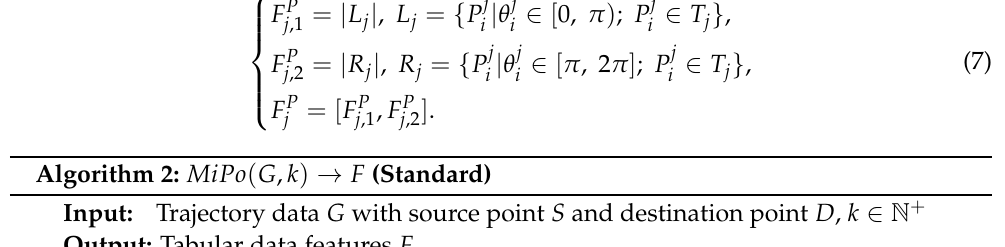
Algorithm 2: MiPo ( G , k ) → F